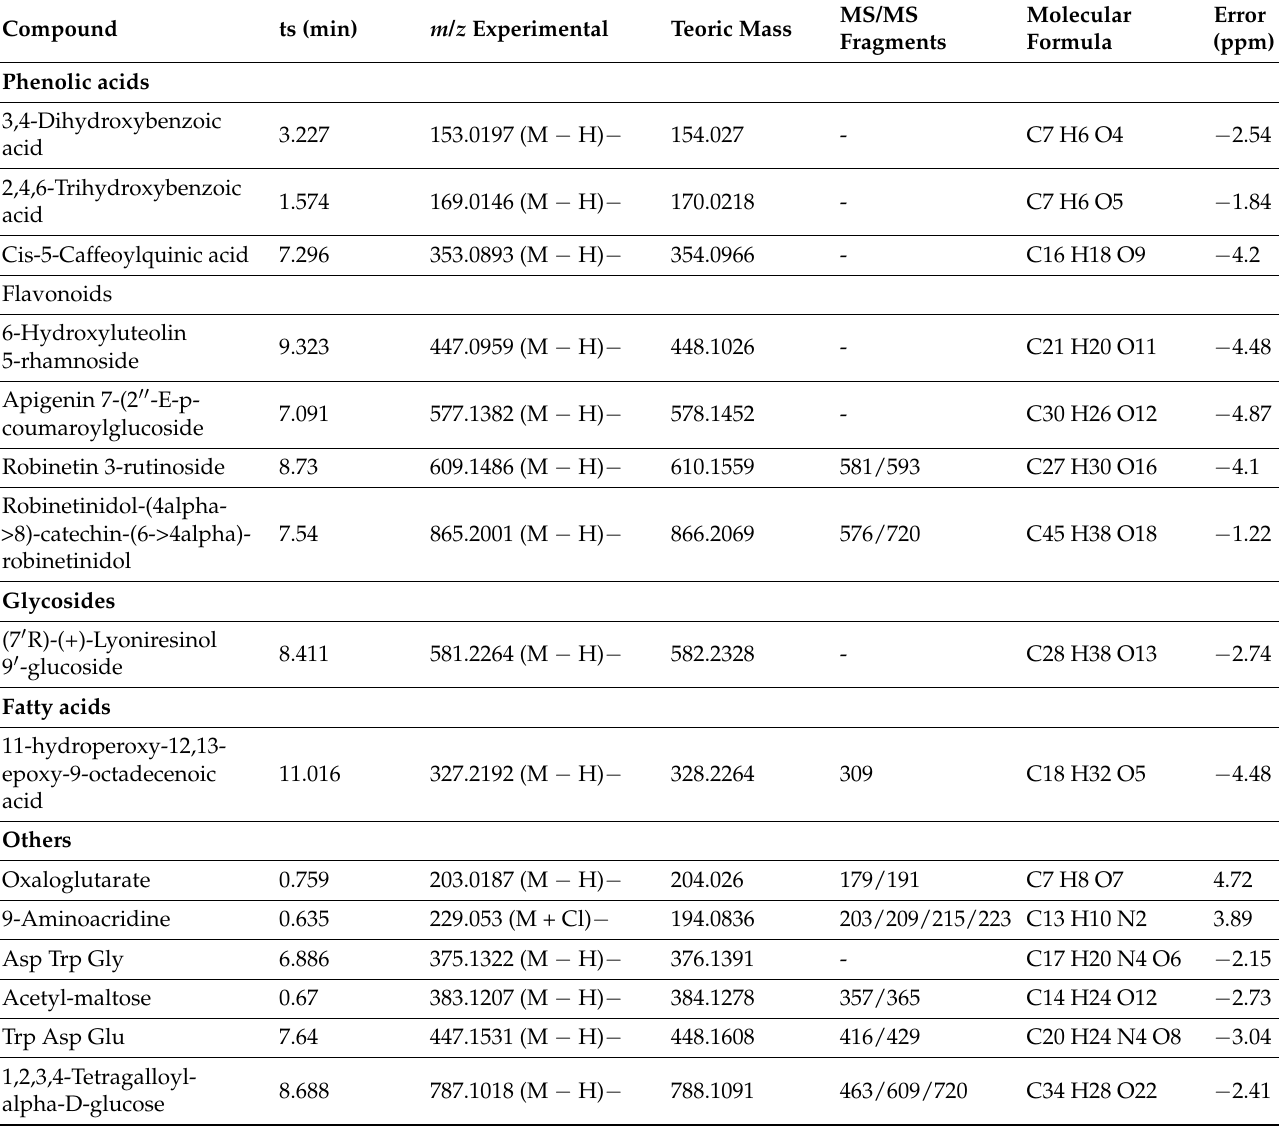
Table 4. Phytochemical profile of the aqueous extract of A. angustiloba leaves by LC–MS in the negative ion